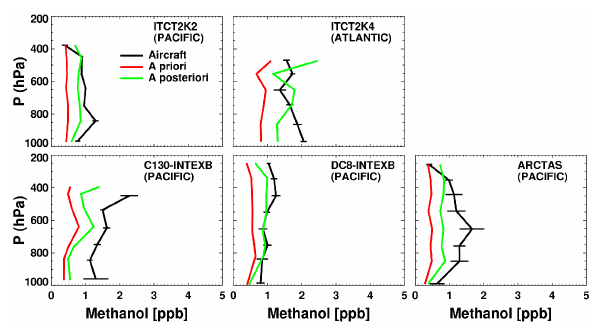
Fig. 9. Vertical profiles of methanol concentrations over ocean. Each profile represents a campaign average over the region spec- ified in the panel. Aircraft measurements are shown in black with the ± 95% confidence limits for each vertical bin indicated by the horizontal bars. The red line is the a priori GEOS-Chem simulation, and the green line is the GEOS-Chem simulation after a posteriori scaling factors have been applied.